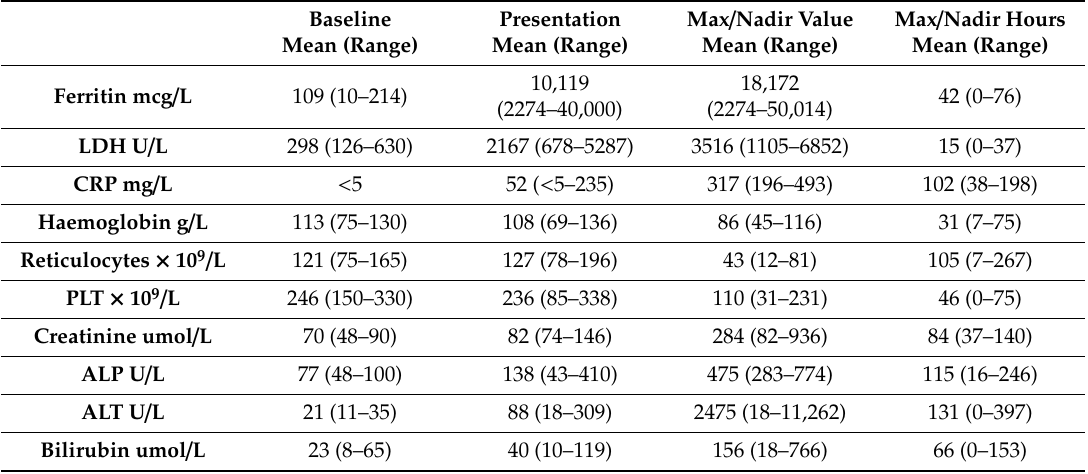
Table 3. Haematological and biochemical parameters at onset and evolution (hours from presentation) during